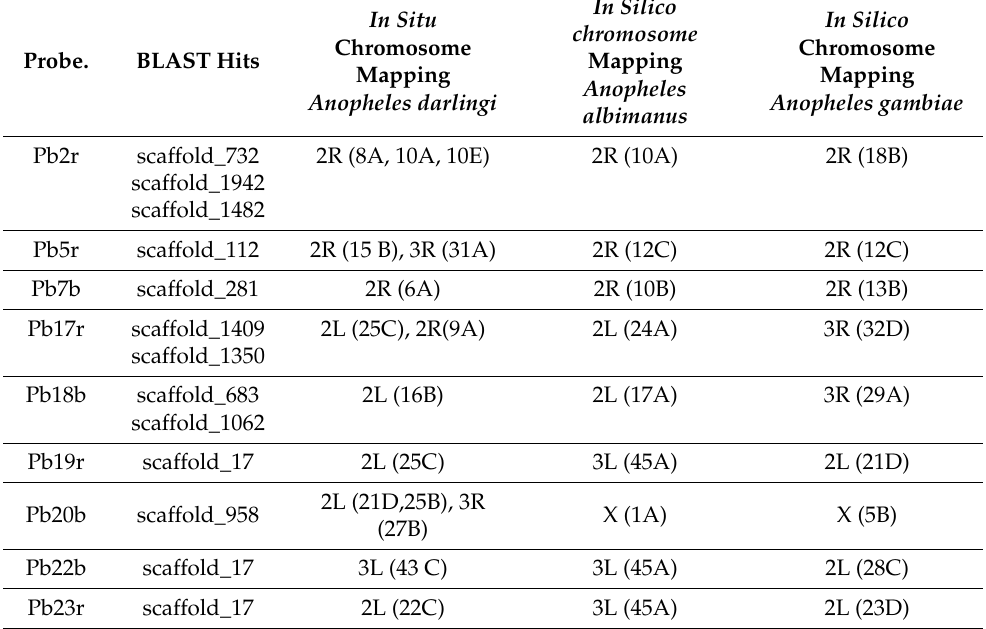
Table 1. In situ localization of probes in An. darlingi chromosomes and in silico identification of equivalent sequences in An. albimanus and An. gambiae chromosomes. Details of BLAST hits locations within An. darlingi scaffolds and probes FASTA files are available in Supplementary Files. In Situ Chromosome Probe.